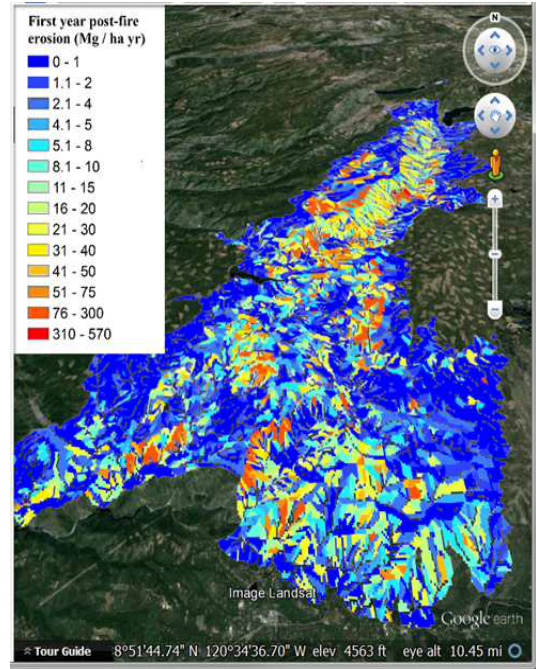
Figure 7. Post-fire hillslope erosion predictions for the King fire displayed in Google